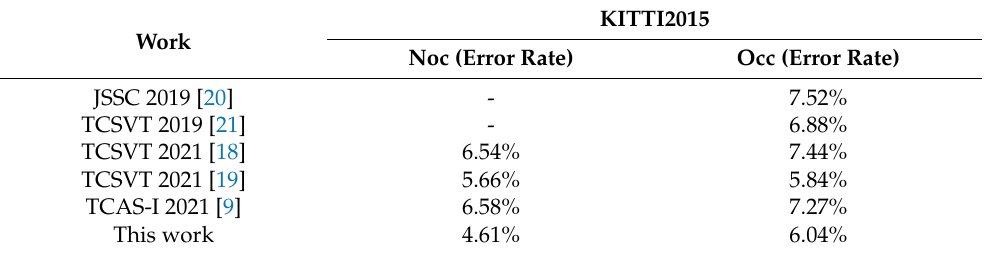
Table 2. Comparison of the error rate.